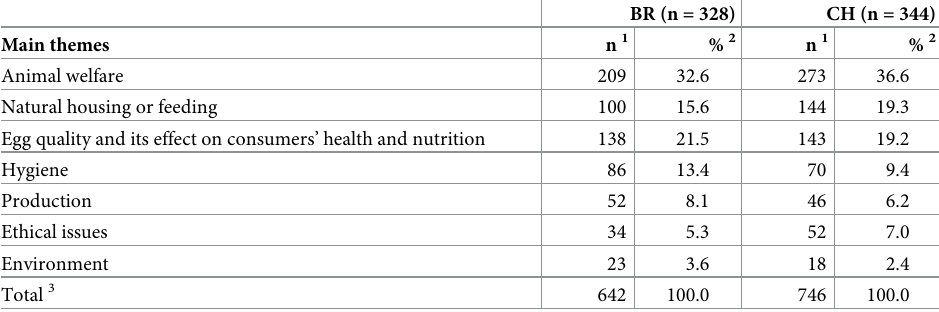
Table 2. Emerging themes in responses by Brazilian (BR) and Chilean (CH) consumers to the questions, What do you considerto be an ideal egg productionfarm ?and Why do you considerthesecharacteristics important